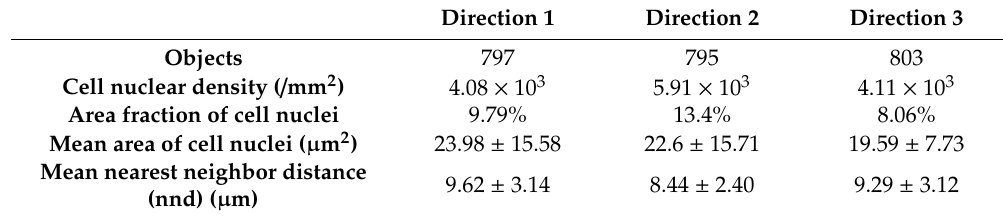
Figure 4. Liver histology revealing the tissue’s homogeneity and isotropy. ( a ) Direction 1, ( b ) Direction 2, and ( c ) Direction 3. Liver tissues were fixed with 10% formalin at the load-free condition. Table 3. Image analysis results from Figure 4a–c revealing the tissue’s homogeneity and